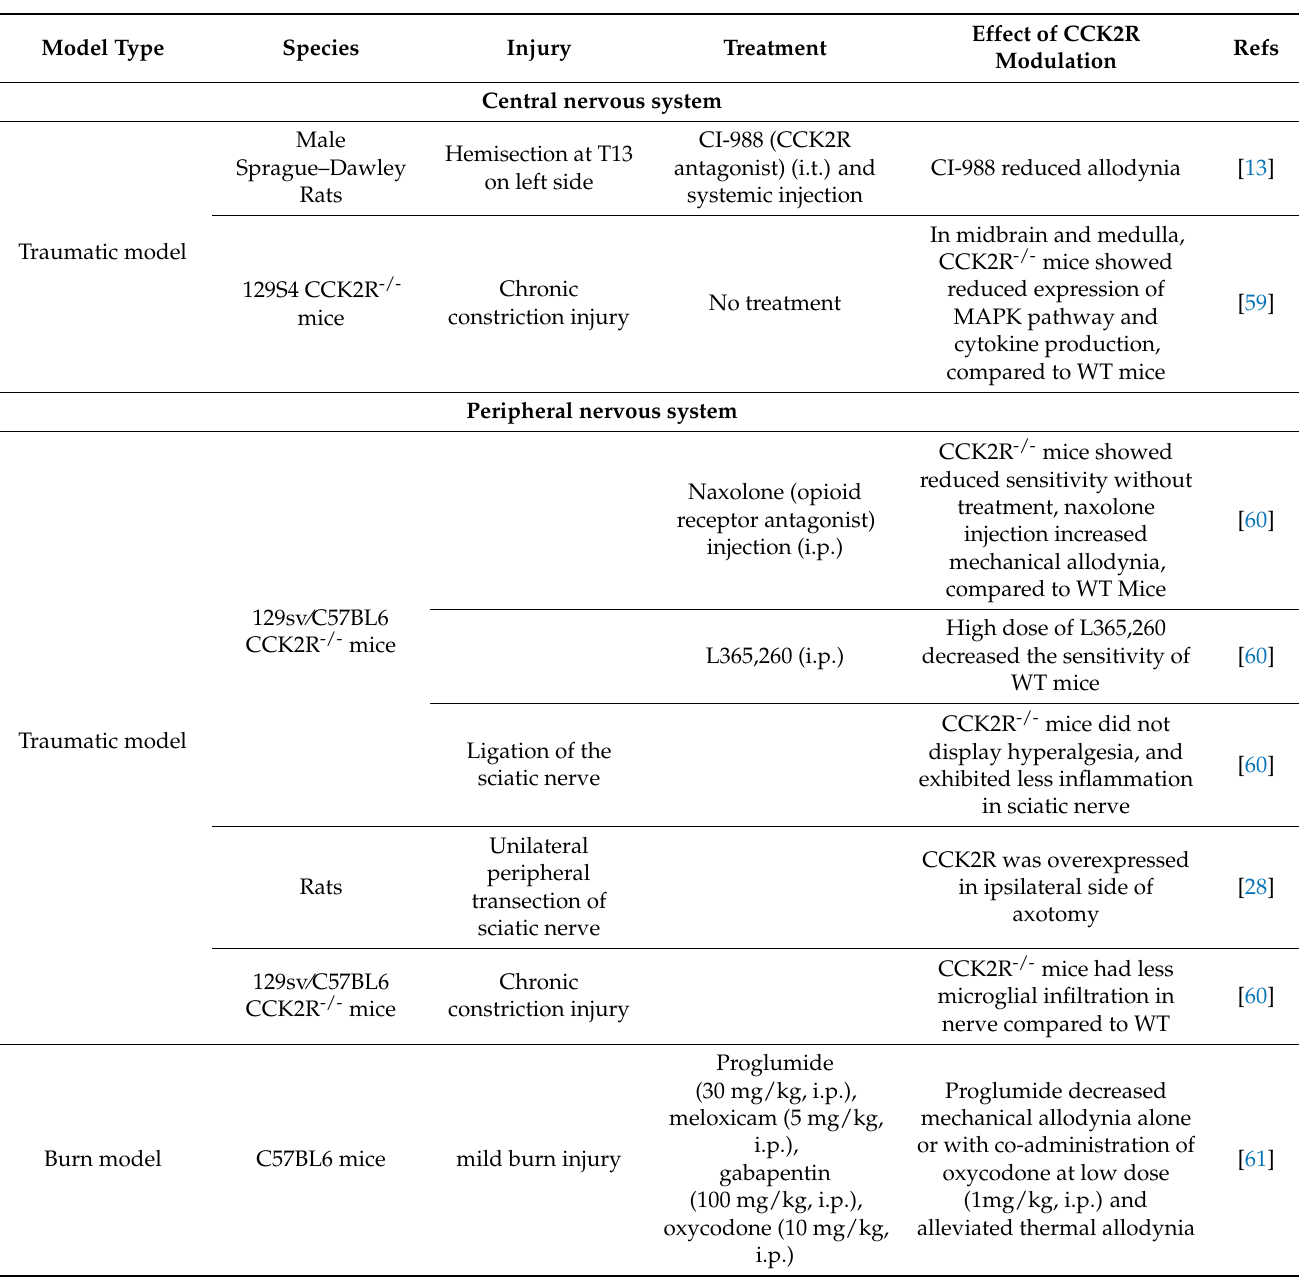
Table 2. Preclinical studies highlighting the role of CCK2R in